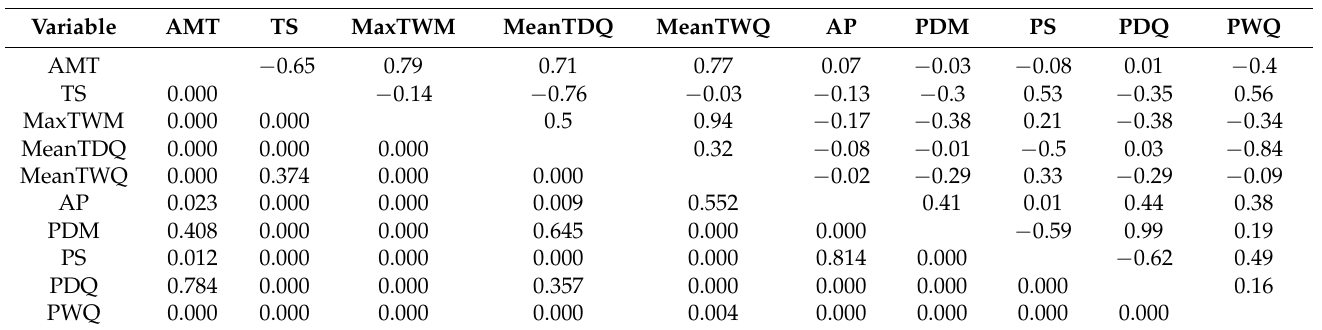
Table 1. Above the diagonal, correlations between bioclimatic variables, indices, and elevation. Below the diagonals, p -values for the significance test. Correlation table for the bioclimatic variables related to aridity.